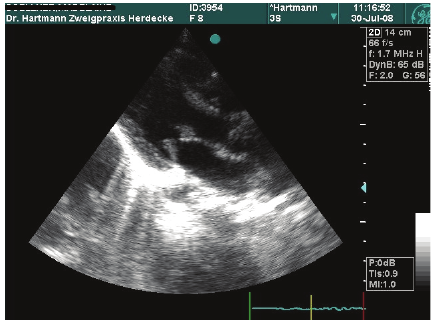
Figure 1: Picture showing a long axis view of the heart during diastolic opening of the mitral valve: notice the terminal clubbed thickness of both mitral valves.